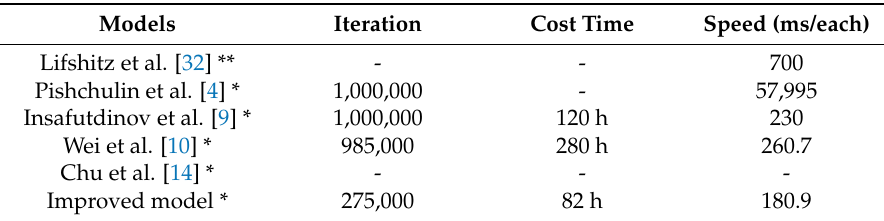
Table 8. The contrasted details of the six models.